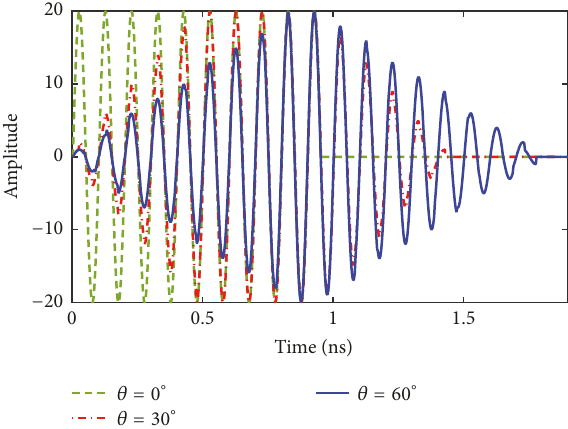
Figure 4: Pulse dispersion at scan angles of 0, 30, and 60 degrees.